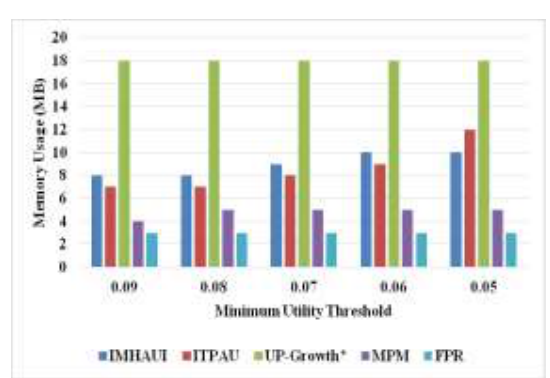
Figure 11. Hepatitis Memory